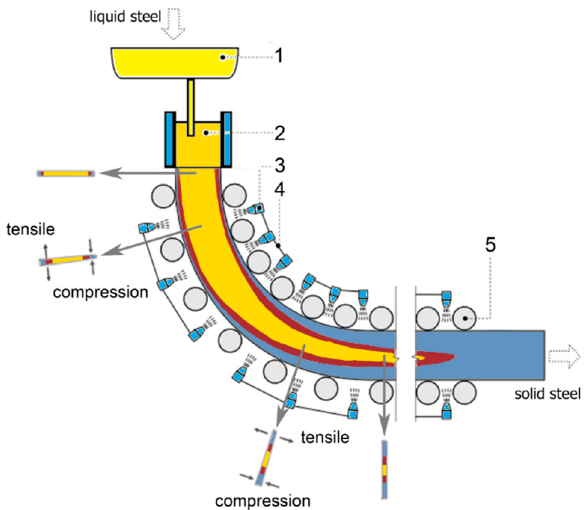
Figure 1. Scheme of the continuous casting and mechanical stresses during bending and straightening. 1—tundish; 2—mould; 3—nozzle; 4—cooling circuit; 5—roller.